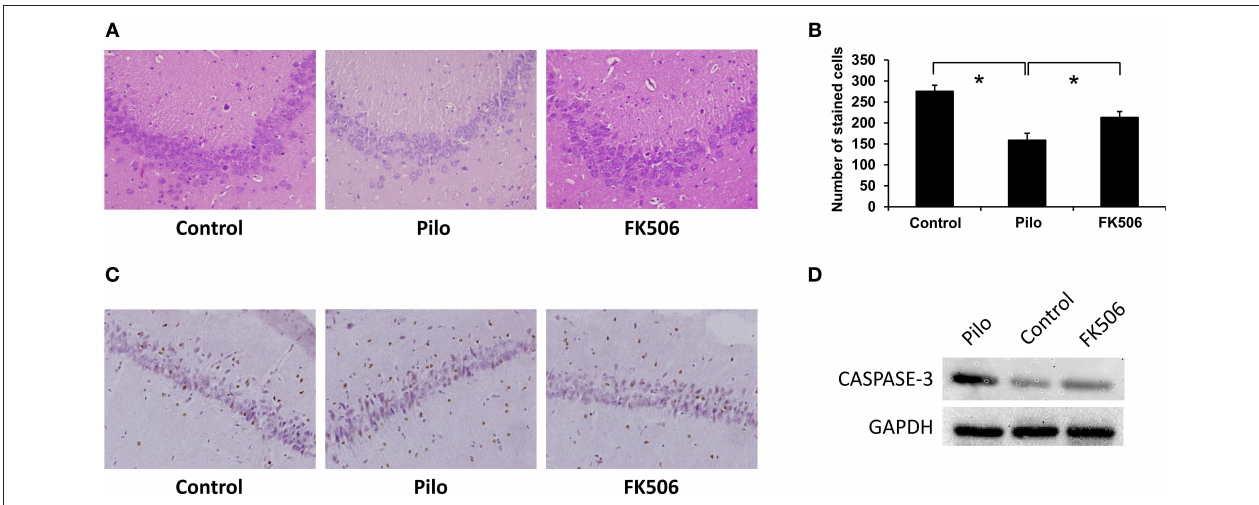
FIGURE 1 | Changes of neuronal loss in the hippocampus of rats in different treatment groups. (A) Morphological changes (HE staining) of the hippocampus in different treatment groups after 7 days of modeling. Magnification: 400 X. (B) Unbiased quantification of HE stained pyramidal CA3 cells. * P < 0.05. (C) Caspase-3 expression in the control group, epilepsy group, and FK506 group after 7 days of modeling detected by immunohistochemistry. Magnification: 400 X. (D) Protein expression of Caspase-3 in the control group, epilepsy group, and FK506 group after 7 days of modeling detected by western blotting.